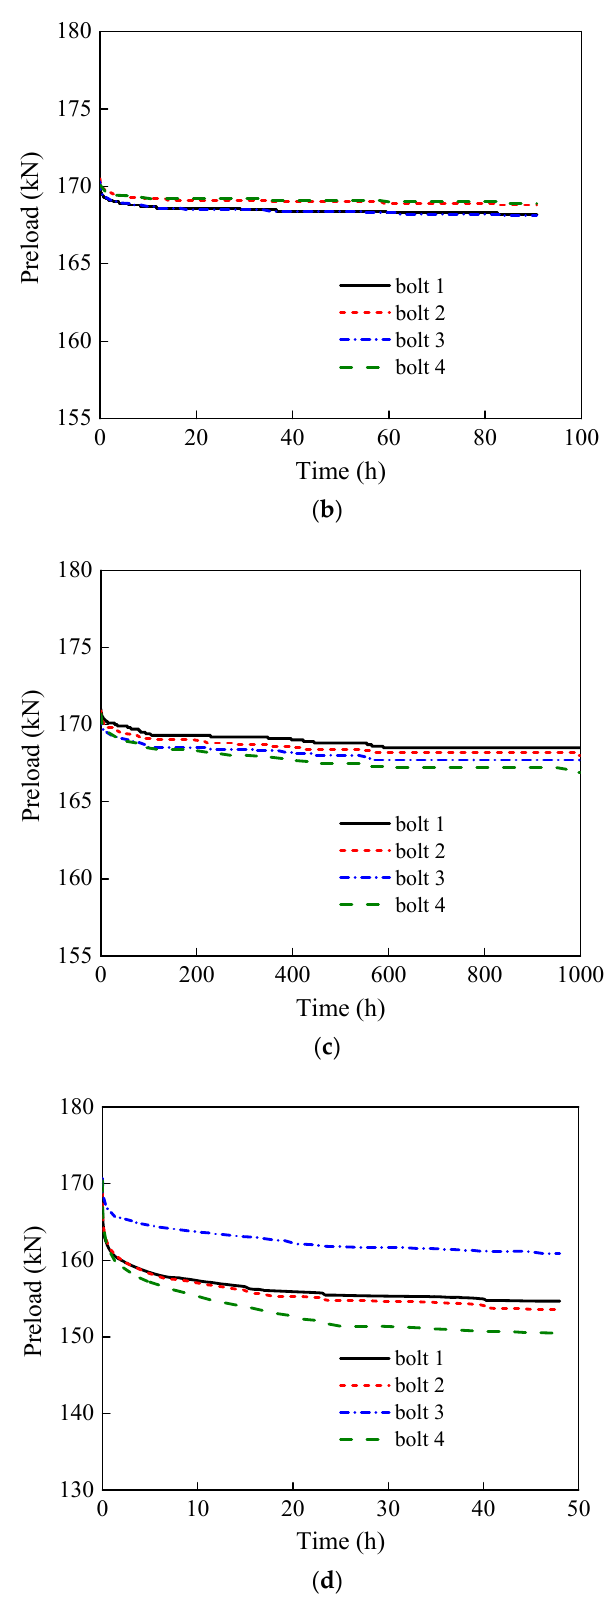
Figure 11. Preload relaxation curves. ( a ) Stainless steel high-strength bolt Group 1. ( b ) Stainless steel high-strength bolt Group 2. ( c ) Stainless steel high-strength bolt Group 3. ( d ) Class 10.9 carbon steel high-strength